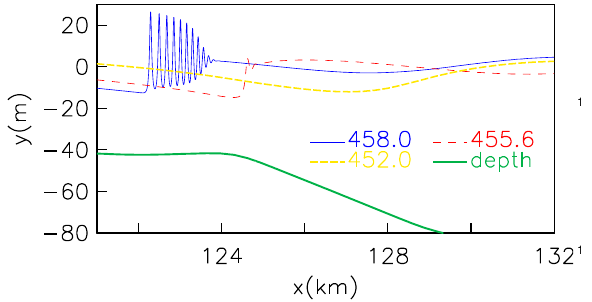
Fig. 15. Evolution of an undular bore from the second crest on the continental shelf of North Carolina. Waves propagate to the left. y is the surface elevation ( η ), x is the distance and the numbers in the legends correspond to the propagation time in minutes.